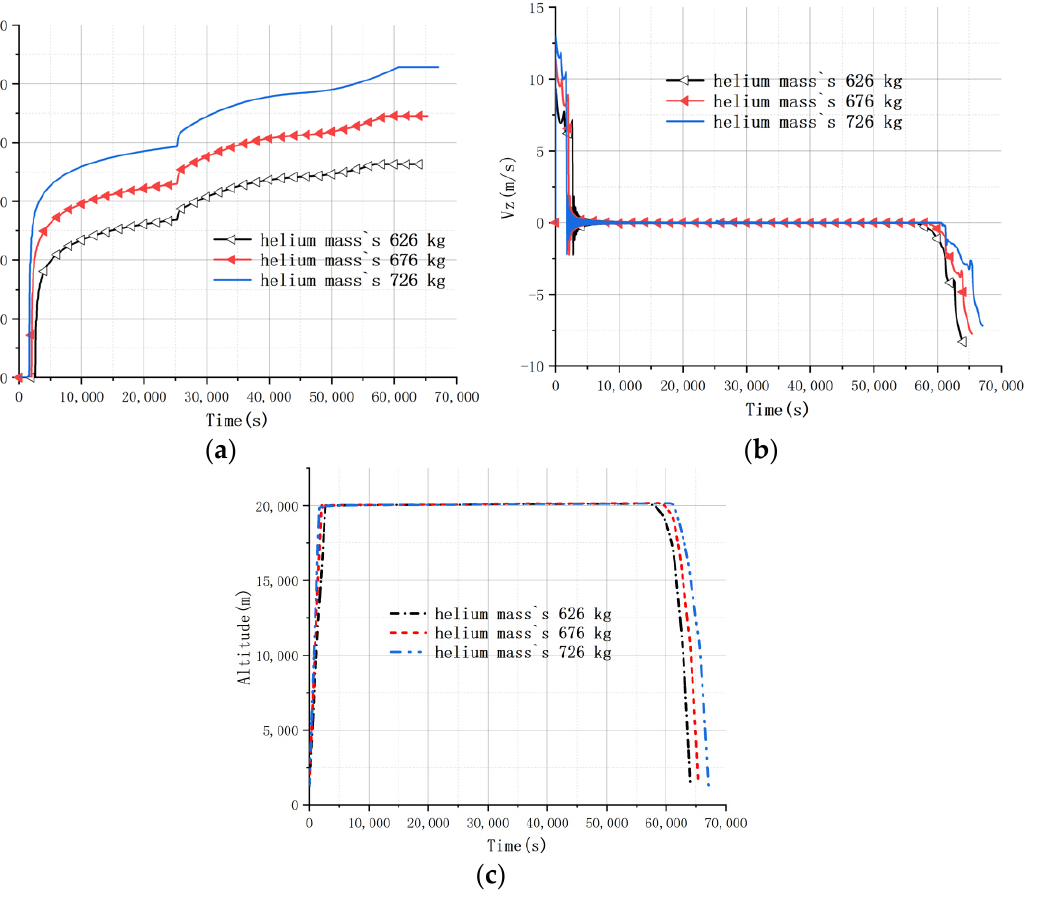
Figure 13. Diagrams corresponding to different initial masses of helium. ( a ) shows the total mass of exhausted helium vs. time, ( b ) shows the change in vertical velocity and ( c ) shows the change in altitude.